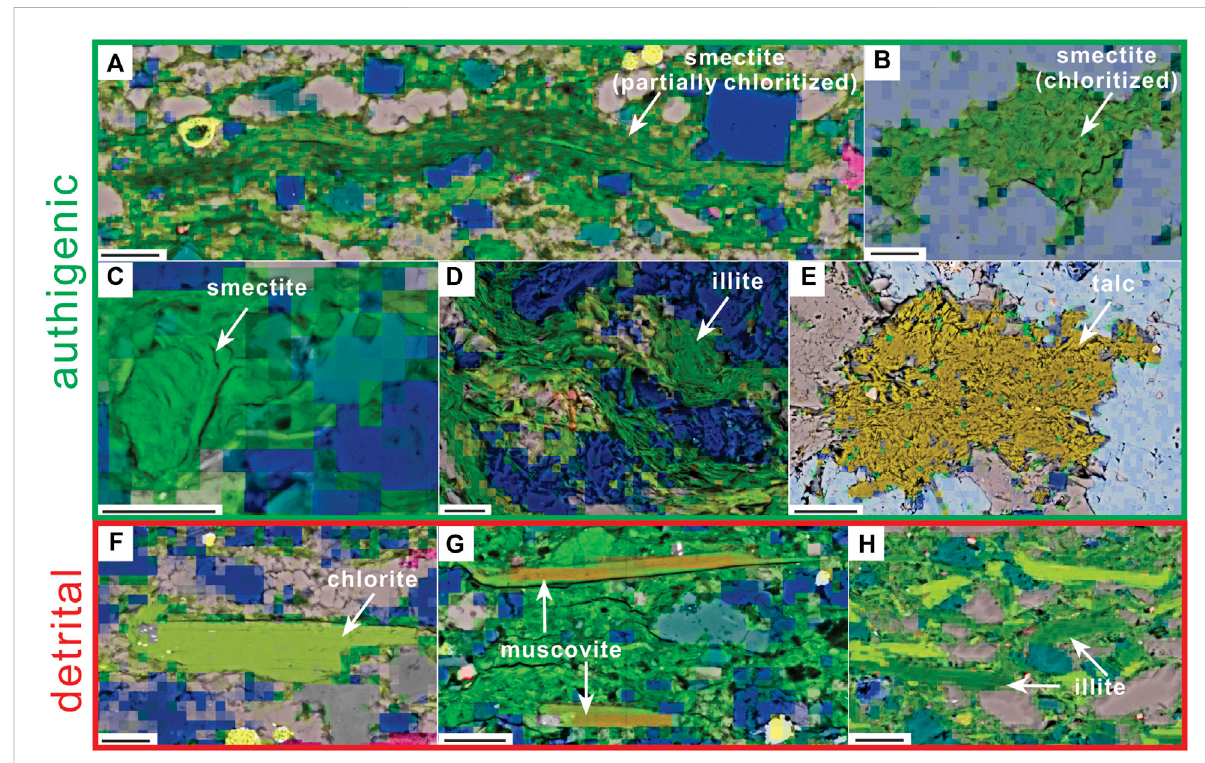
FIGURE 7 Representative petrographic images of authigenic and detrital clay minerals. Scale bars represent 10 μ m. Mineral false colors are the same as in Figure 2 (A – G) are samples from the Doushantuo Formation. h is a sample from the Enorama Shale. (A) Wavy laminae of authigenic smectite (saponite, partially chloritized). Individual particles in wavy laminae display mostly bedding-parallel orientation, due to compaction; individual laminae are largely free of detrital grains, indicating they are not transported together with detrital fraction; (B) pore- fi lling chloritized saponite with individual particles showing random orientation due to sheltering from compaction. (C) Smectite intragranular pore- fi ll in feldspar. Feldspar helps to resist compaction so that smectite is randomly oriented; (D) fi ne-grained authigenic illite curved by compaction, showing distinct texture against detrital illite in (H) ; (E) authigenictalc concretion with individual particles randomly oriented; (F) detrital chlorite with discrete grain boundary and clear cleavage; (G) muscovite grains embedded in authigenic saponite; (H) detrital illite associated with other detrital minerals of similar